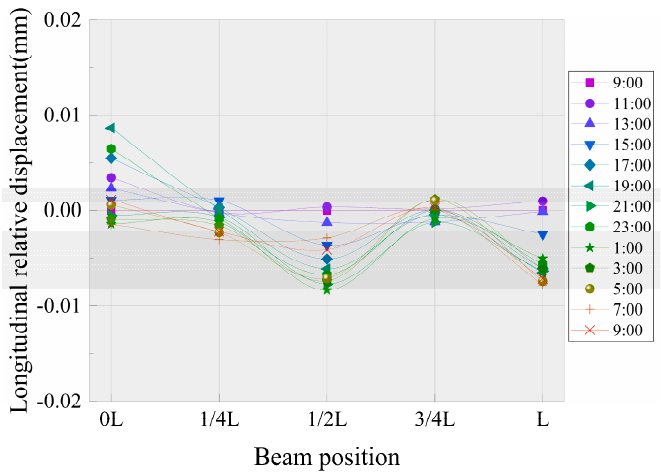
Figure 12. Displacement between the track slab and base plate.